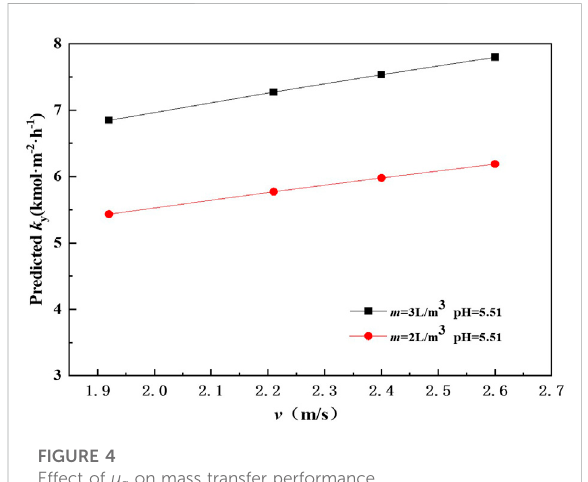
FIGURE 6 Effect of pH on mass transfer